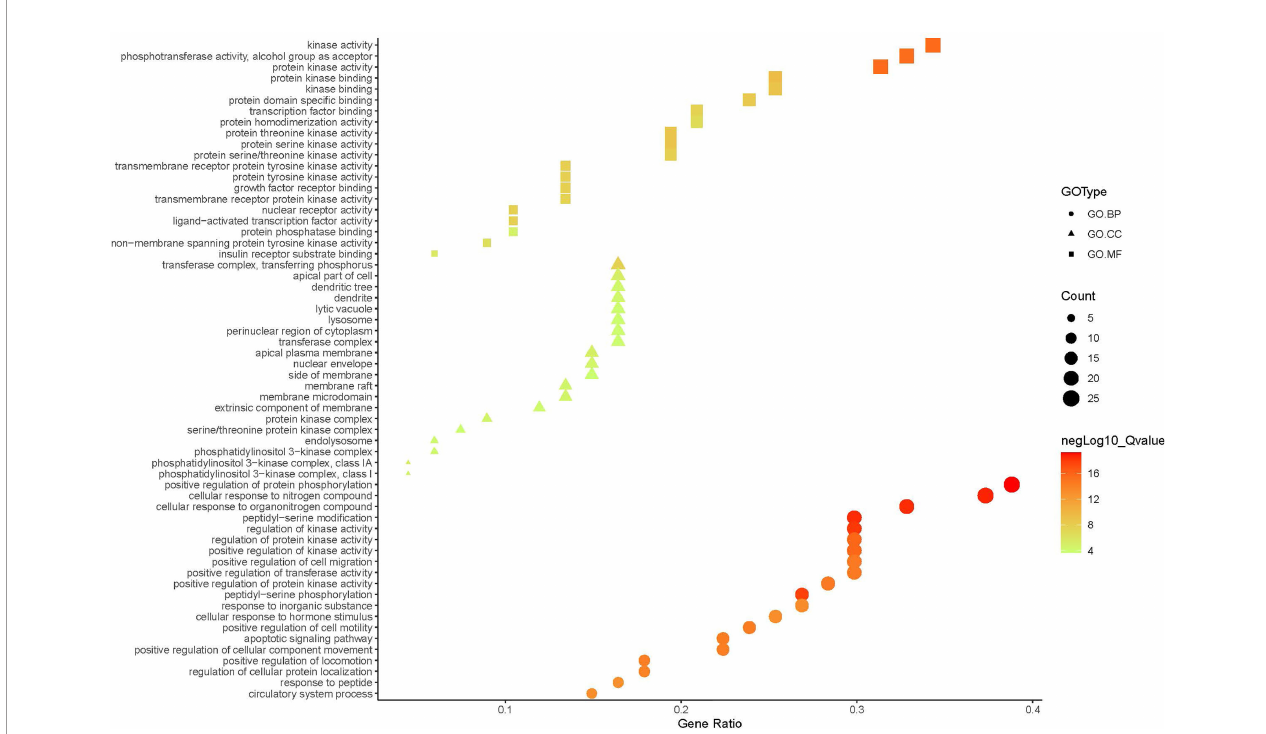
FIGURE 5 | The GO.MF, GO.BP and GO.CC enrichment analysis plot of TFDR. The size and color of nodes represent the count and – log10(q) values of molecular functions, biological processes, and cellular components